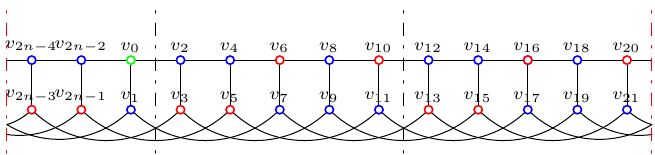
Figure 5. Segment of f in Case 1.1 in Lemma 7.